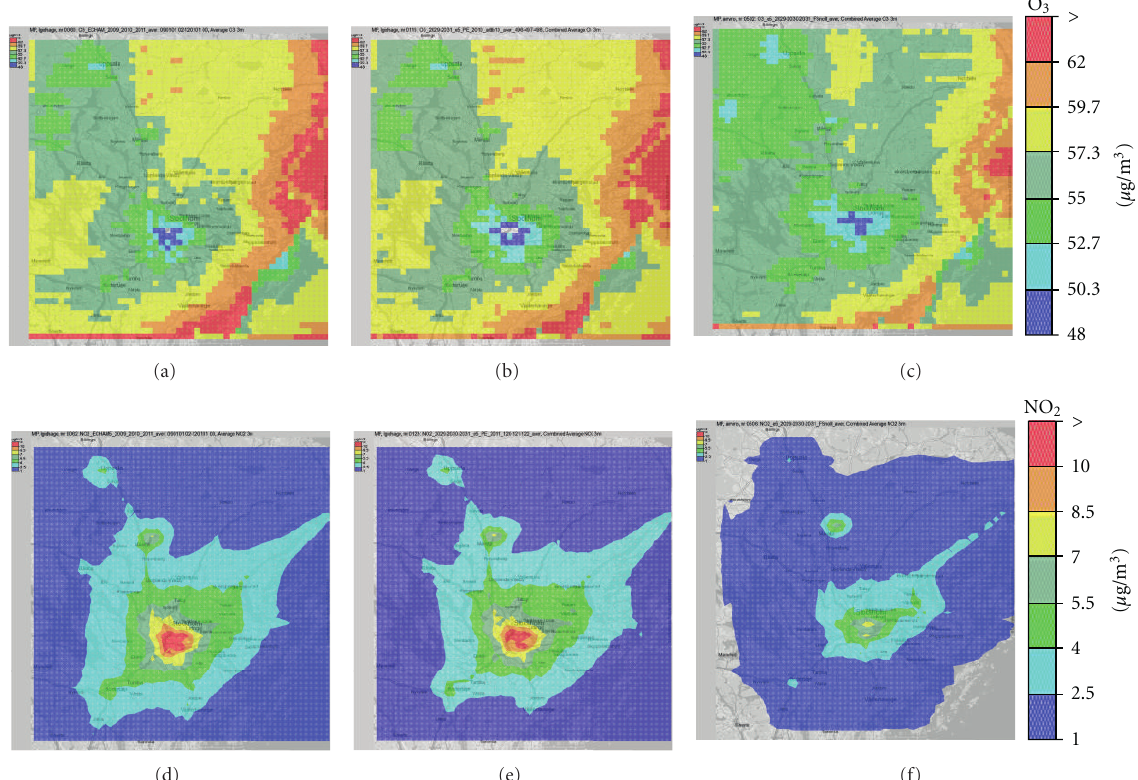
Figure 4: Simulated three-year-average O 3 (top) and NO 2 (bottom) concentrations in 2009–2011 (case i, left), 2029–2031 (case ii, middle), and 2029–2031 (case iv, right) in the downscaled area over the Stockholm region, based on ECHAM5 A1B-r3 climate and RCP4.5 emissions in Europe.